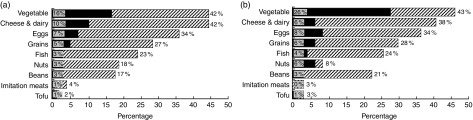
Reported frequency of foods eaten in non-meat meals, for (a) non-meat reducers and (b) meat reducers (, often; , always), in a nationally representative adult sample: USA, 2015. Figure depicts stratified percentage of ‘often’ and ‘always’ responses to the question ‘For meals without meat, how often do you eat _____’, by meat reduction behaviour